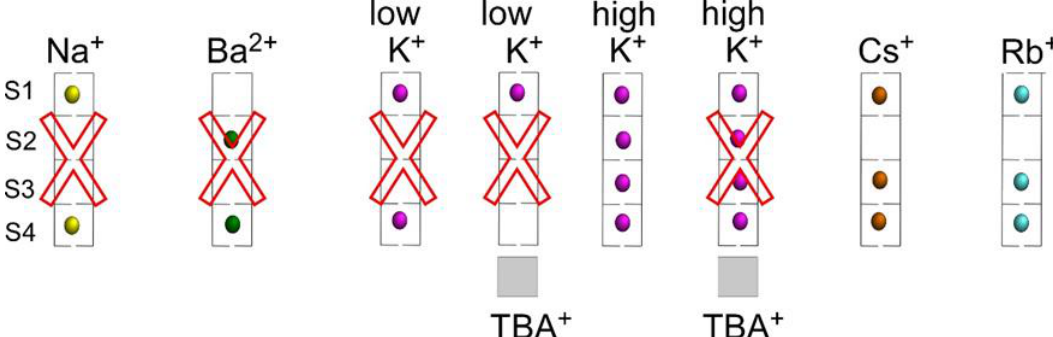
Figure 9. Idealized potential occupation of the KcsA selectivity filter by Na + , Ba 2+ , K + , Cs + and Rb + , in the presence or absence of TBA + bound to the channel’s vestibule. Red crosses indicate nonconductive conformations for the selectivity filter under those experimental conditions. The PDB entries used for these models are: 2ITC (Na + ), 2ITD (Ba 2+ ), 1K4D (low K + ), 2HVJ (low K + , TBA + ), 1K4C (high K + ), 2HVK (high K + , TBA + ), 1R3L (Cs + ) and 1R3I (Rb + ).